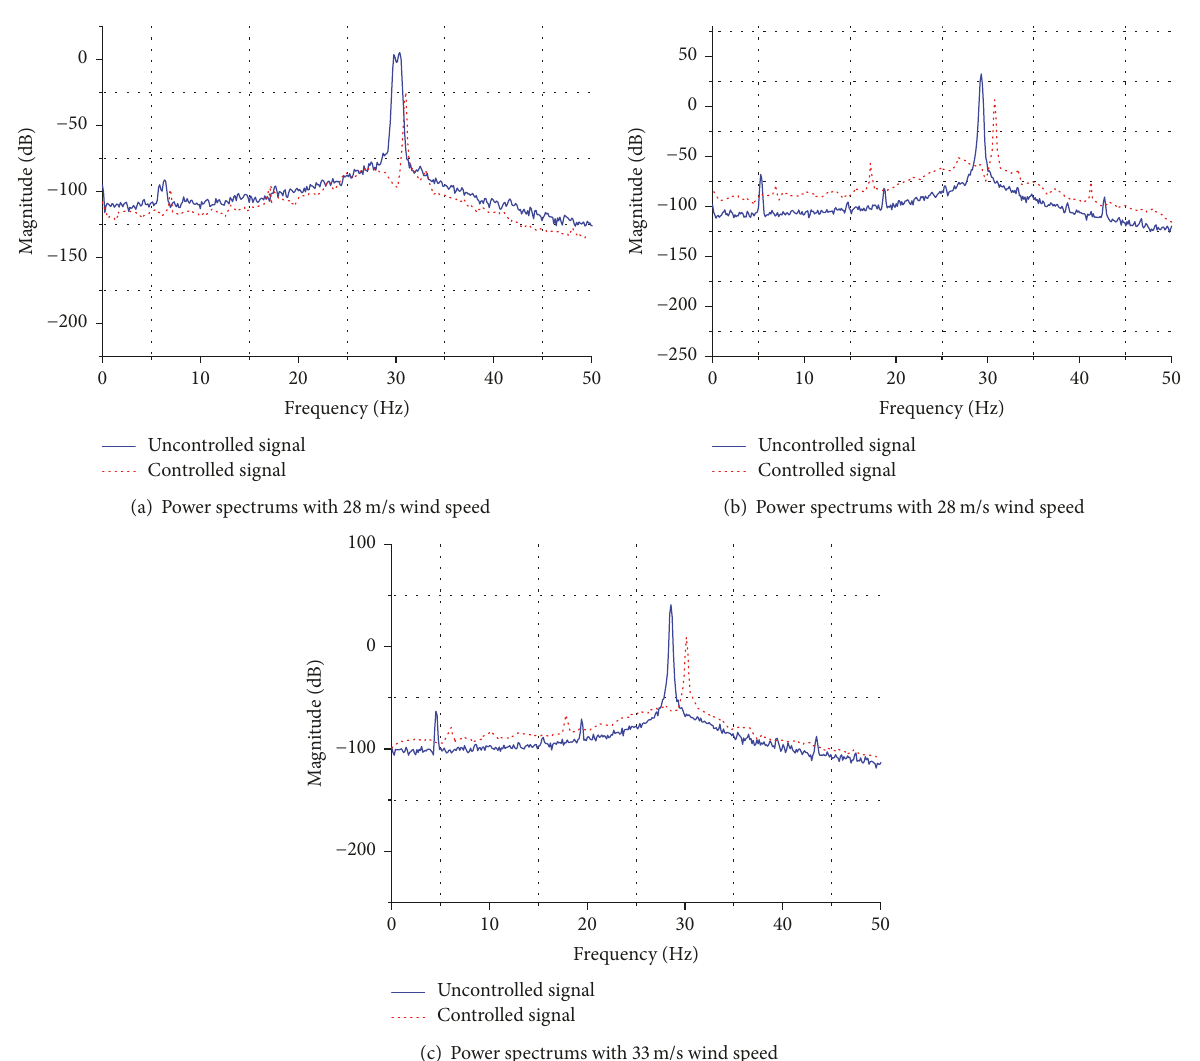
Figure 12: Comparison of power spectrum with different